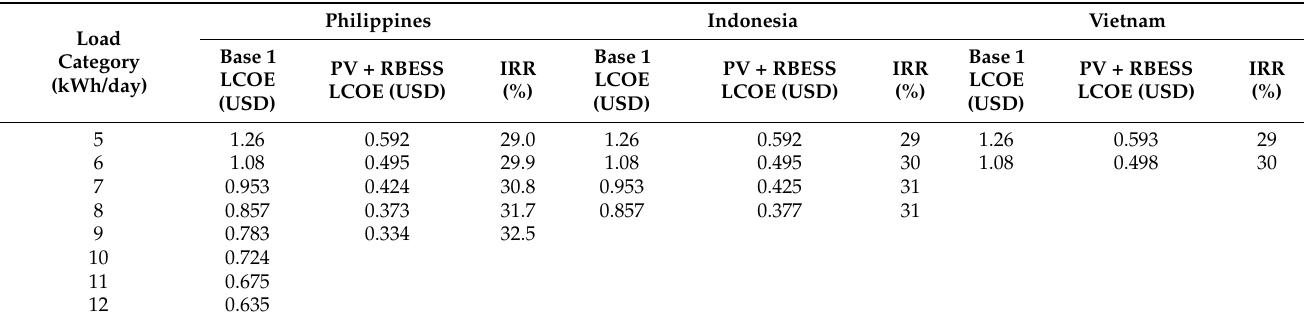
Table 9. Comparative economic feasibility analysis for Base 1 system.